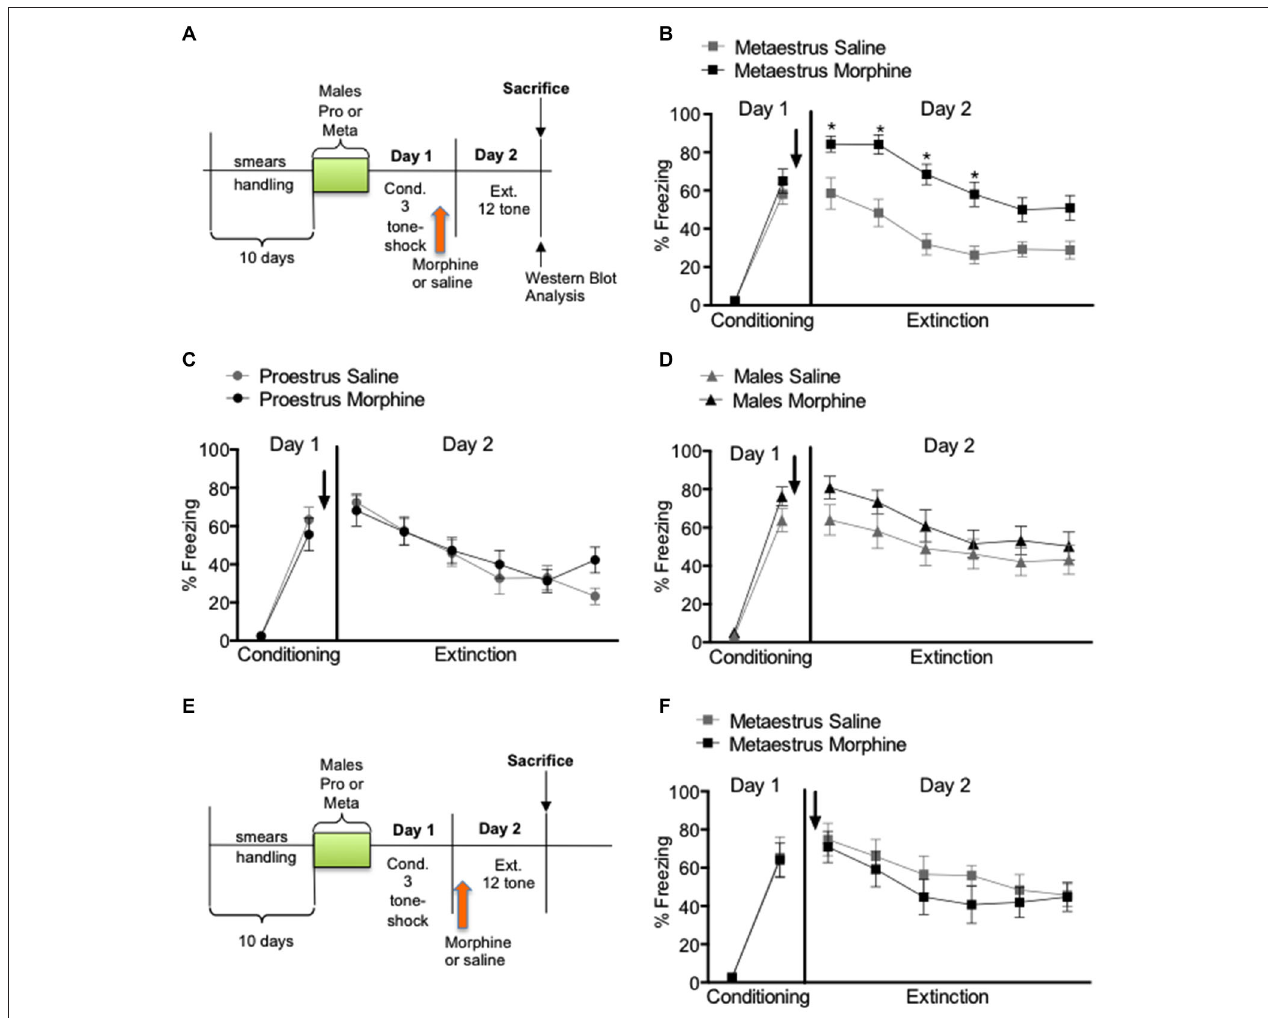
injections of morphine given during the proestrus stage had no effect either in the consolidation of fear conditioning or within session extinction (morphine n = 13, saline n = 14). (D) Post-training injections of morphine had no effect either in the consolidation of fear conditioning or within session extinction in male rats (morphine n = 15, saline n = 14). (E) Experimental timeline. (F) Pre-extintion injections of morphine given after the metaestrus stage had no effect either in the consolidation of fear conditioning or extinction (morphine n = 8, saline n =